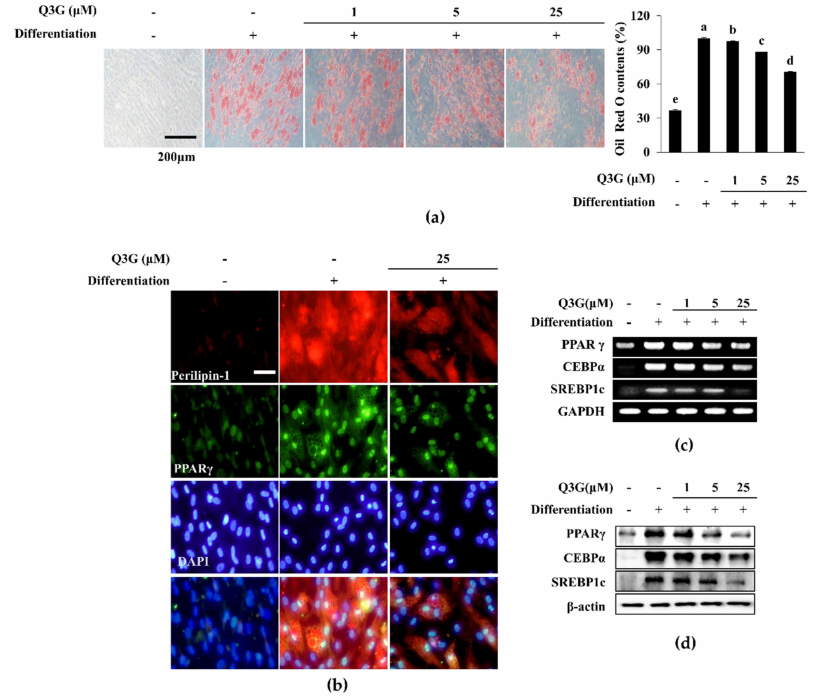
Figure 6. E ff ect of Q3G on adipogenic di ff erentiation of hBM-MSCs. ( a ) E ff ect of Q3G on the intracellular lipid accumulation in adipo-induced hBM-MSCs at day 10 of di ff erentiation. Lipid droplets were stained with Oil Red O and the quantification was carried out by measuring absorbance values of retained dye. Lipid accumulation level was given as relative percentage of Oil Red O dye compared to adipo-induced untreated group. Di ff erent letters (a–e) indicate statistically significant di ff erence ( p < 0.05) among groups. ( b ) E ff ect of Q3G on the expression of perilipin-1 and PPAR γ in adipo-induced hBM-MSCs at day 10 di ff erentiation analyzed by immunofluorescence staining. DAPI staining was used to highlight the nucleus of viable cells. Scale bar: 50 µ m. E ff ect of Q3G on the expression of adipogenic marker genes ( c ) and proteins ( d ). Analysis of gene and protein expression of adipo-induced hBM-MSCs was carried out by RT-PCR and Western blot, respectively, at day 10 of di ff erentiation. GAPDH and β -actin were used as internal loading controls. Q3G was treated with initial di ff erentiation for 3